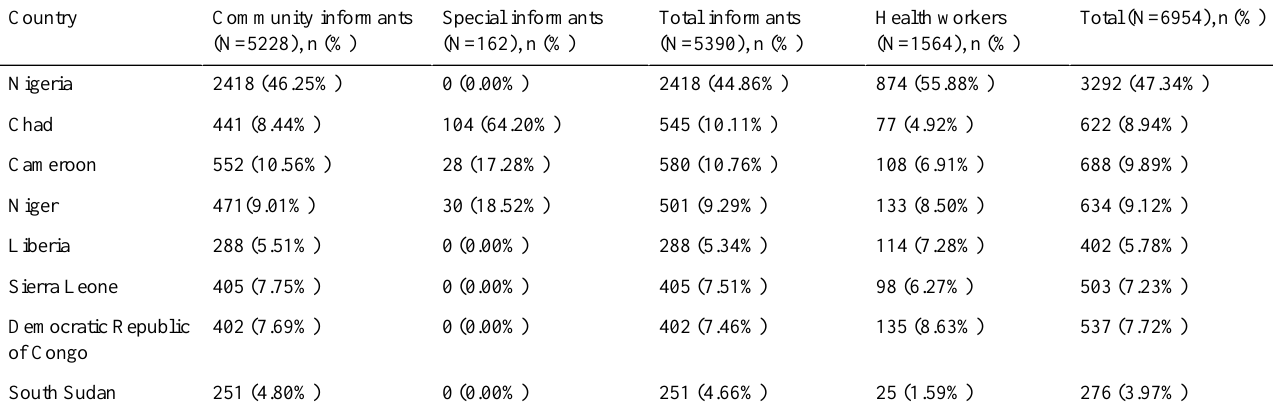
Table 1. Human capital and smartphones engaged for the Auto-Visual Acute Flaccid Paralysis Detection and Reporting (AVADAR) project in eight countries from August 1, 2017, to July 31,